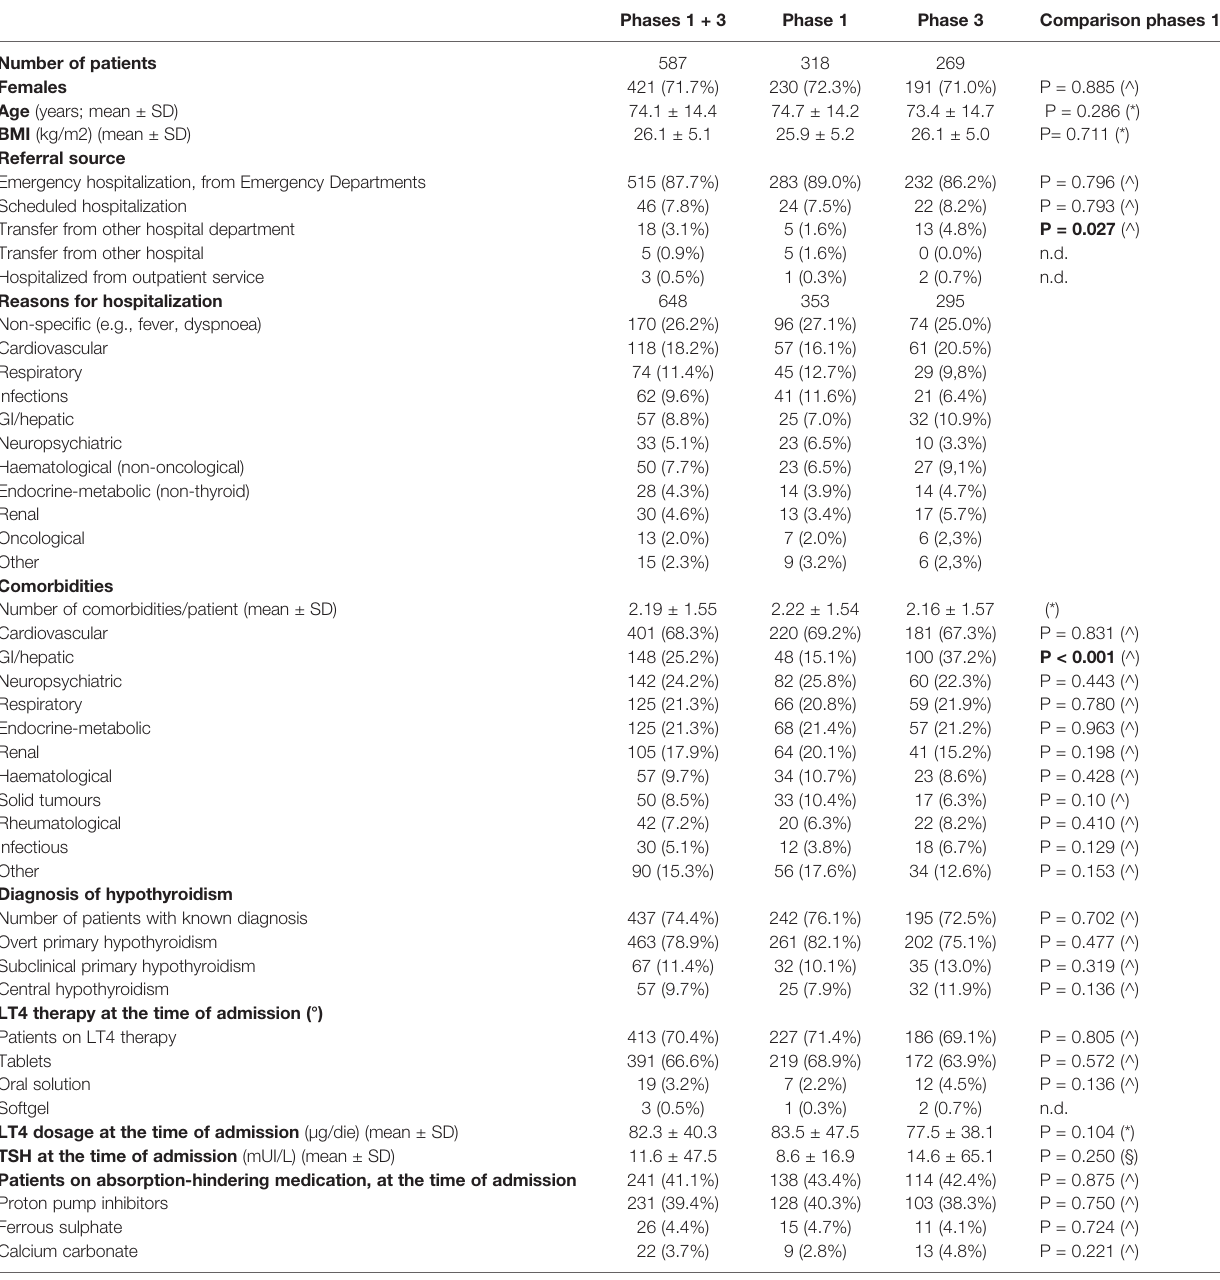
TABLE 2 | Main clinical characteristics of patients enrolled in the study, overall and subdivided by study phase (phases 1 and